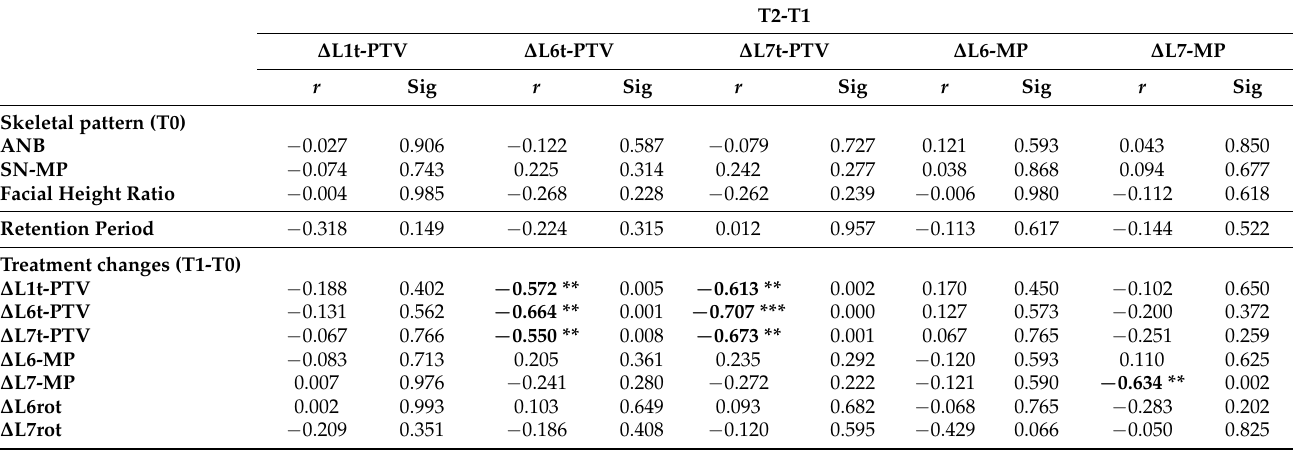
Table 7. Pearson’s correlation coefficients between post-treatment changes and other variables in the